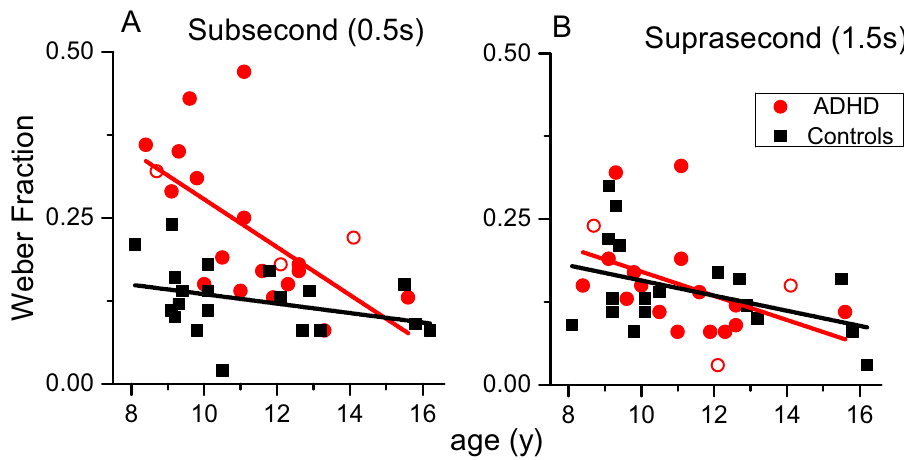
Figure 3. Auditory time thresholds for stimuli in the milliseconds ( A ) and seconds ( B ) ranges as a function of age divided by the two groups (ADHD: red filled circles, ADHD + dyslexia: red open circles, Controls: black squares).